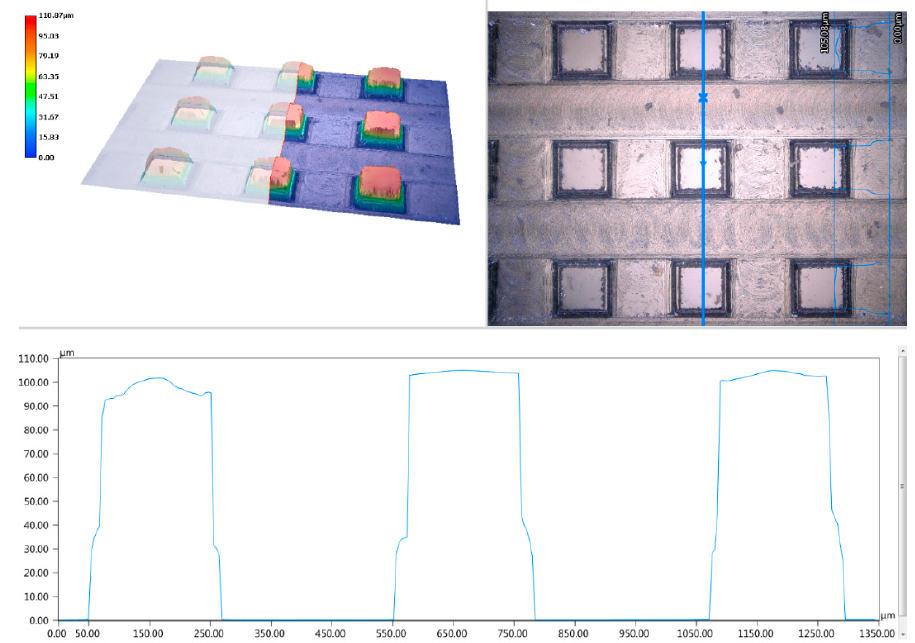
Figure 8. 3D microstructure topography of the square column.